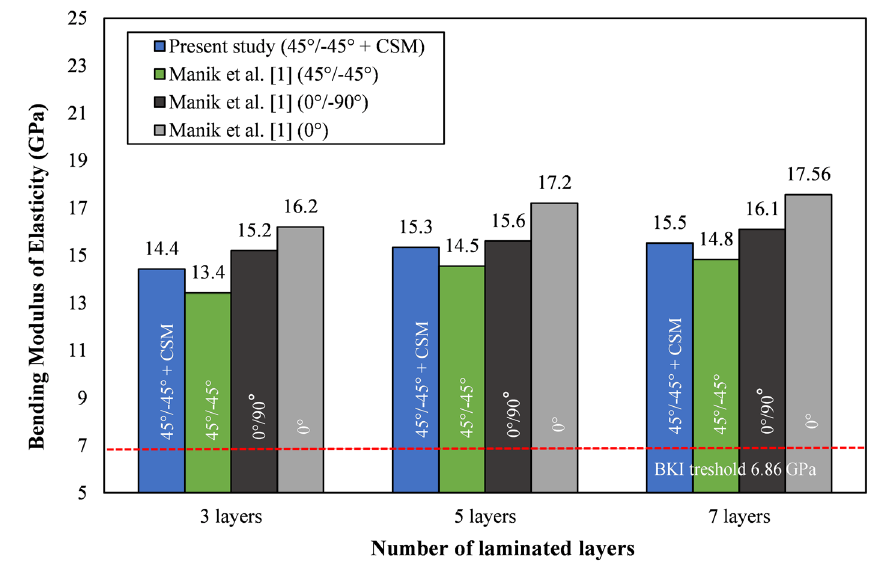
Figure 7: Comparison of bending modulus under di ff erent numbers of